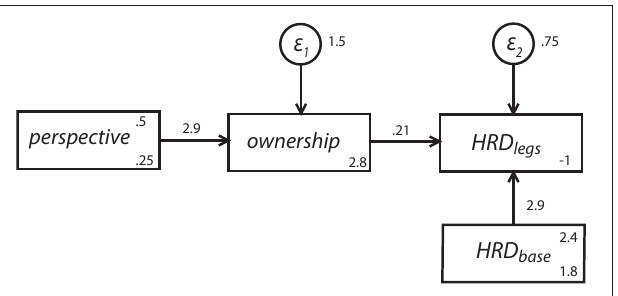
FIGURE 7 | Path analysis model that fits data from experiment 2. The boxes represent the variables: perspective can be 0 or 1 for 3PP and 1PP, respectively; ownership is the response to the questionnaire item mybody ; HRD base is the heart rate deceleration baseline, and HRD legs is the heart rate deceleration measured right after the legs start separating. The circles represent random error terms.